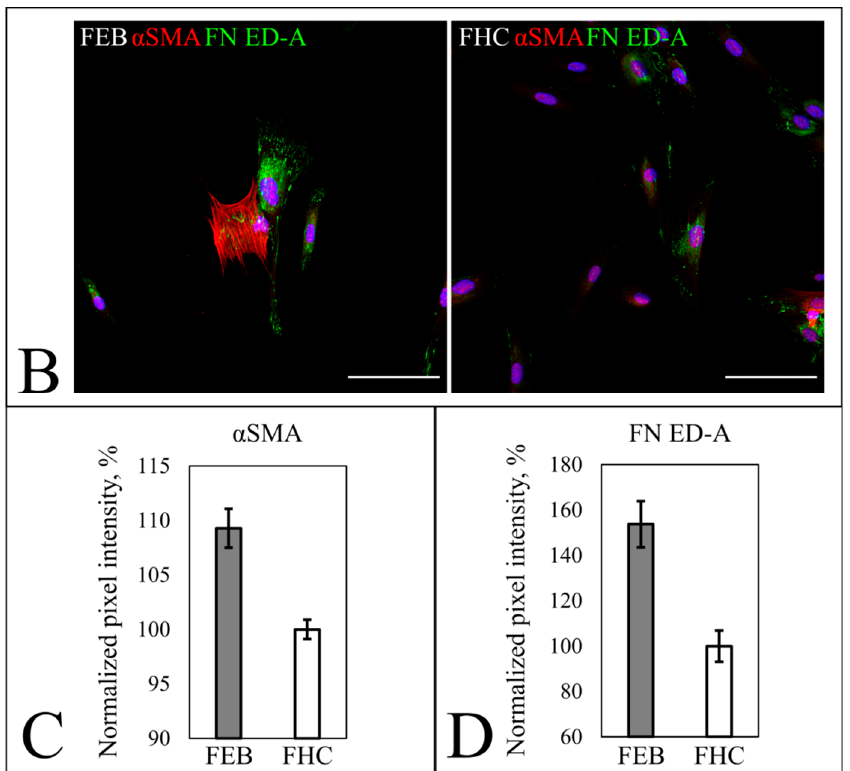
Figure 3. Immunocytochemistry ICC staining of FEB1 (FEB) and FHC1 (FHC). ( A ). Red channel shows markers: COLI—type I collagen; COLIV—type IV collagen; FN—fibronectin; S100A4—fibroblast-specific protein 1; TGL—transgelin; COLVII—type VII collagen. Blue channel shows nuclei (DAPI). Scale bar—100 µ m. Confocal microscopy (COLI, COLIV, FN, S100A4, TGL) and fluorescence microscopy (COLVII). ( B) . Red channel shows ɑ SMA—alpha smooth muscle actin. Green channel shows FN ED ‐ A—the ED ‐ A segment of fibronectin. Blue channel shows nuclei (DAPI). Scale bar—100 μ m. Confocal microscopy. ( C ). ɑ SMA expression level in FEB and FHC lines. Mean value and 95% confidence interval shown for combined FEB (1–4) and FHC1 (FHC). The FHC was taken as 100%. ( D ). FN ED ‐ A expression level in FEB and FHC lines. Mean value and 95% confidence interval shown for combined FEB (1–4) and FHC1 (FHC). The FHC was taken as